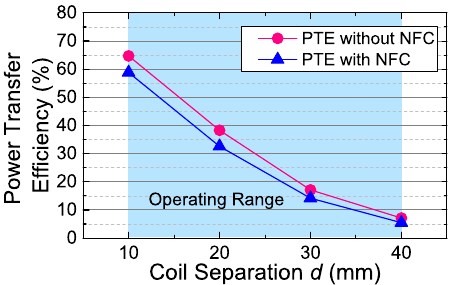
Figure 17. The power transfer efficiency of WPT versus coil separation d with or without connecting the added NFC